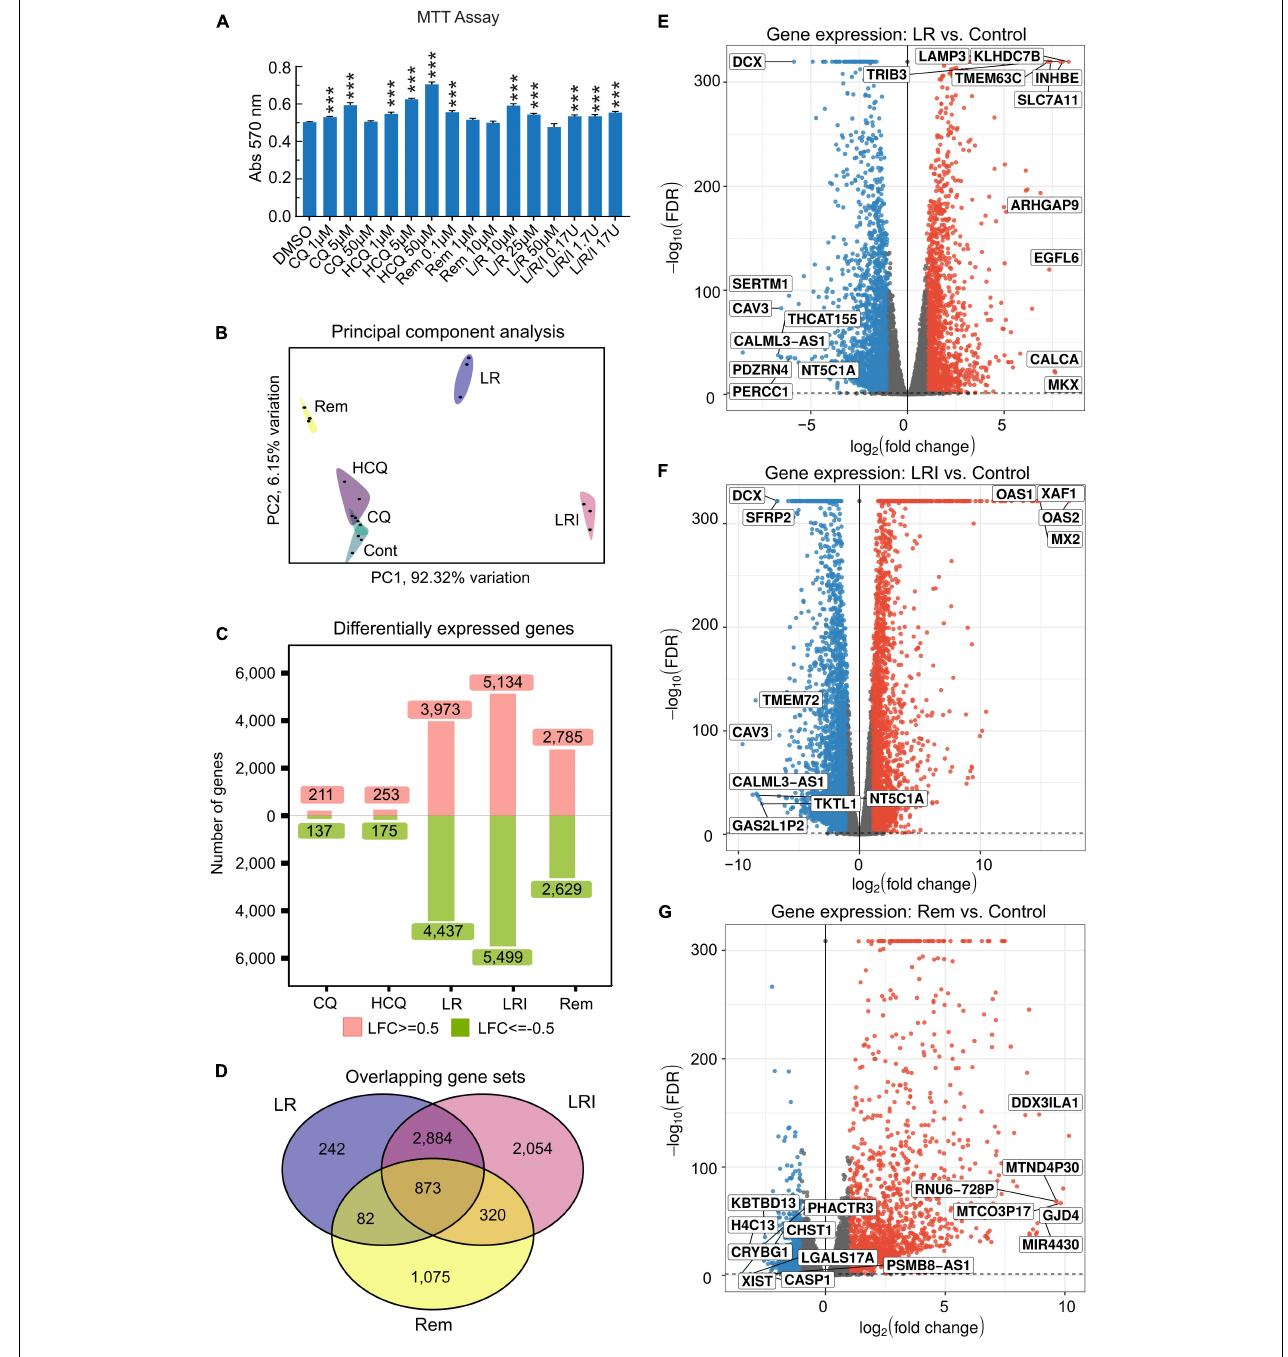
FIGURE 1 | Differences in the response of cardiac myocytes to drug treatments assessed by RNA-seq. (A) Various concentrations of each drug were added to hiPSC-CMs for 24 h, and cell viability was determined using the MTT assay. Absorbance at 570 nm was measured using a plate reader. All the cell viability assays were performed at least three times. L/R/I: 25 µ m L/R + 0.17, 1.7, or 17U interferon. Two-group comparisons were performed using Student’s two-tailed t -test. Data are represented as mean with all error bars indicating ± s.e.m. *** P ≤ 0.001 compared to DMSO control. (B) Principal component analysis of RNA-seq data from hiPSC-CMs treated with the five drugs and control samples. CQ (blue): chloroquine; HCQ (light purple): hydroxychloroquine; LR (dark blue): lopinavir/ritonavir; LRI (pink): lopinavir/ritonavir + interferon- β ; Rem (yellow): remdesivir. (C) Absolute numbers of differentially expressed genes downregulated (green: Log2 fold change ≤ 0.5) and upregulated (red: Log2 fold change ≥ 0.5) after treatments compared to control. (D) Shared differentially expressed genes between LR, LRI, and Rem. (E,F) Differential expression of genes shown in volcano plots in panel (E) , LR vs. control, in panel (F) , LRI vs. control, and in panel (G) , Rem vs. control. Blue: significantly downregulated, red: significantly upregulated, gray: not significantly expressed, FDR ≤ 0.05.